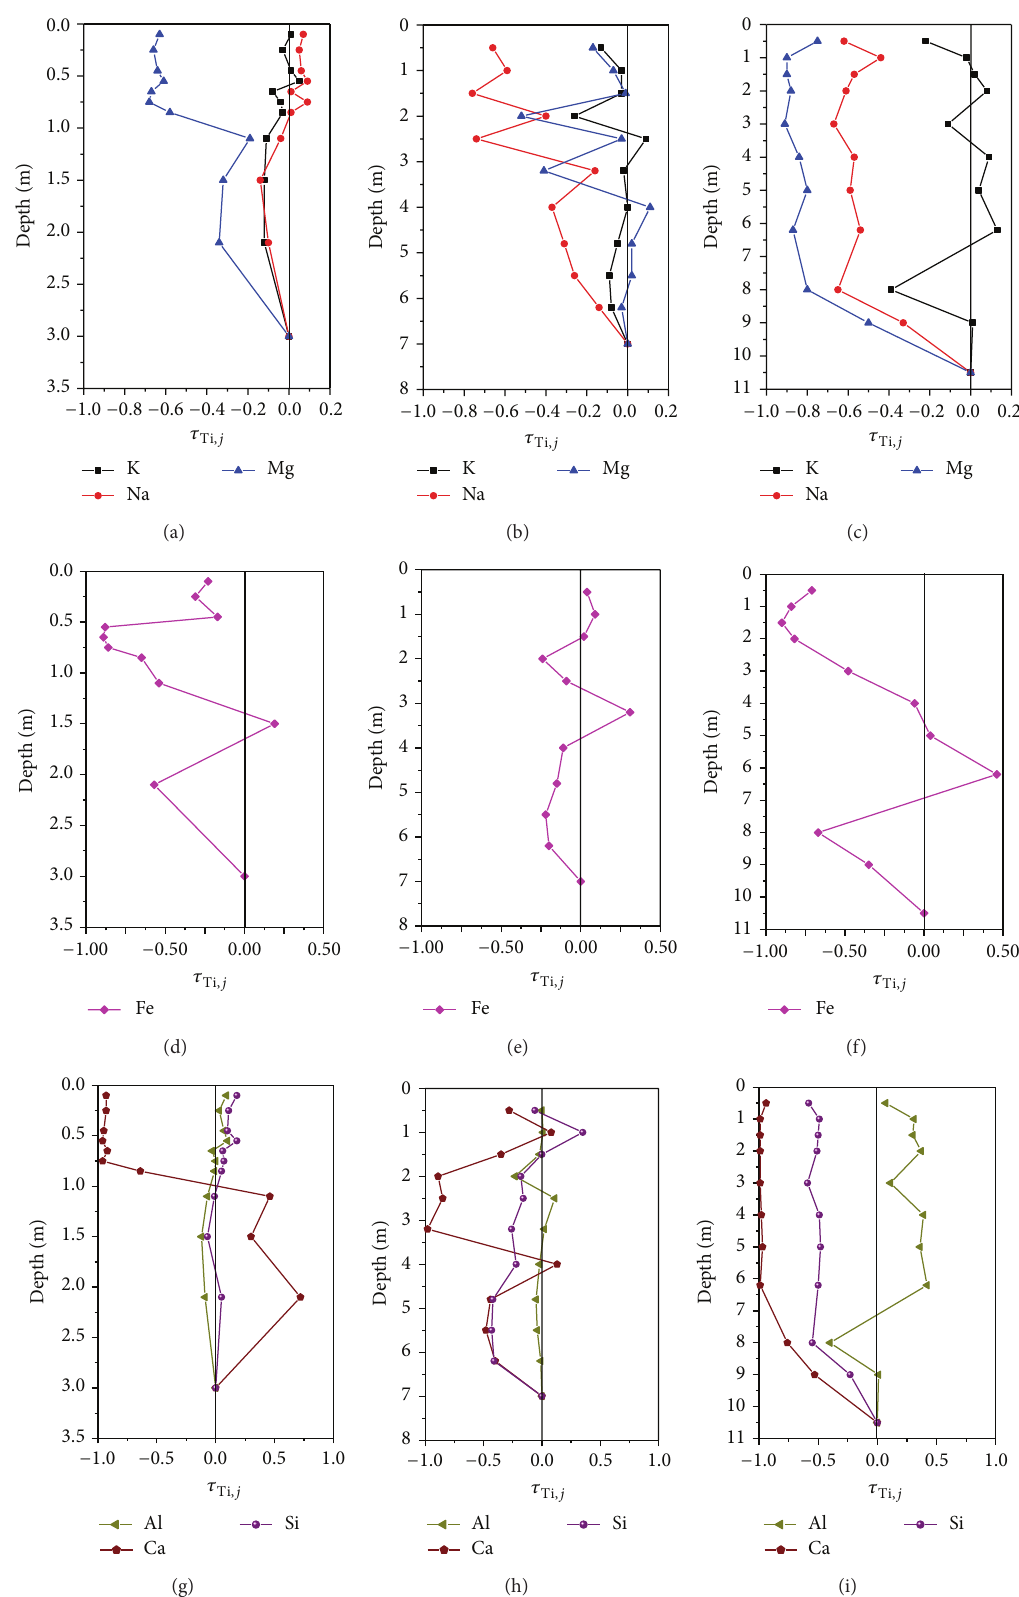
Figure 3: Depth profiles for Tau values for major elements in profile A (left panel: (a), (d), and (g)), B (middle panel: (b), (e), and (h)), and C (right panel: (c), (f), and (i)). A = ridge; B = near mountaintop; C =